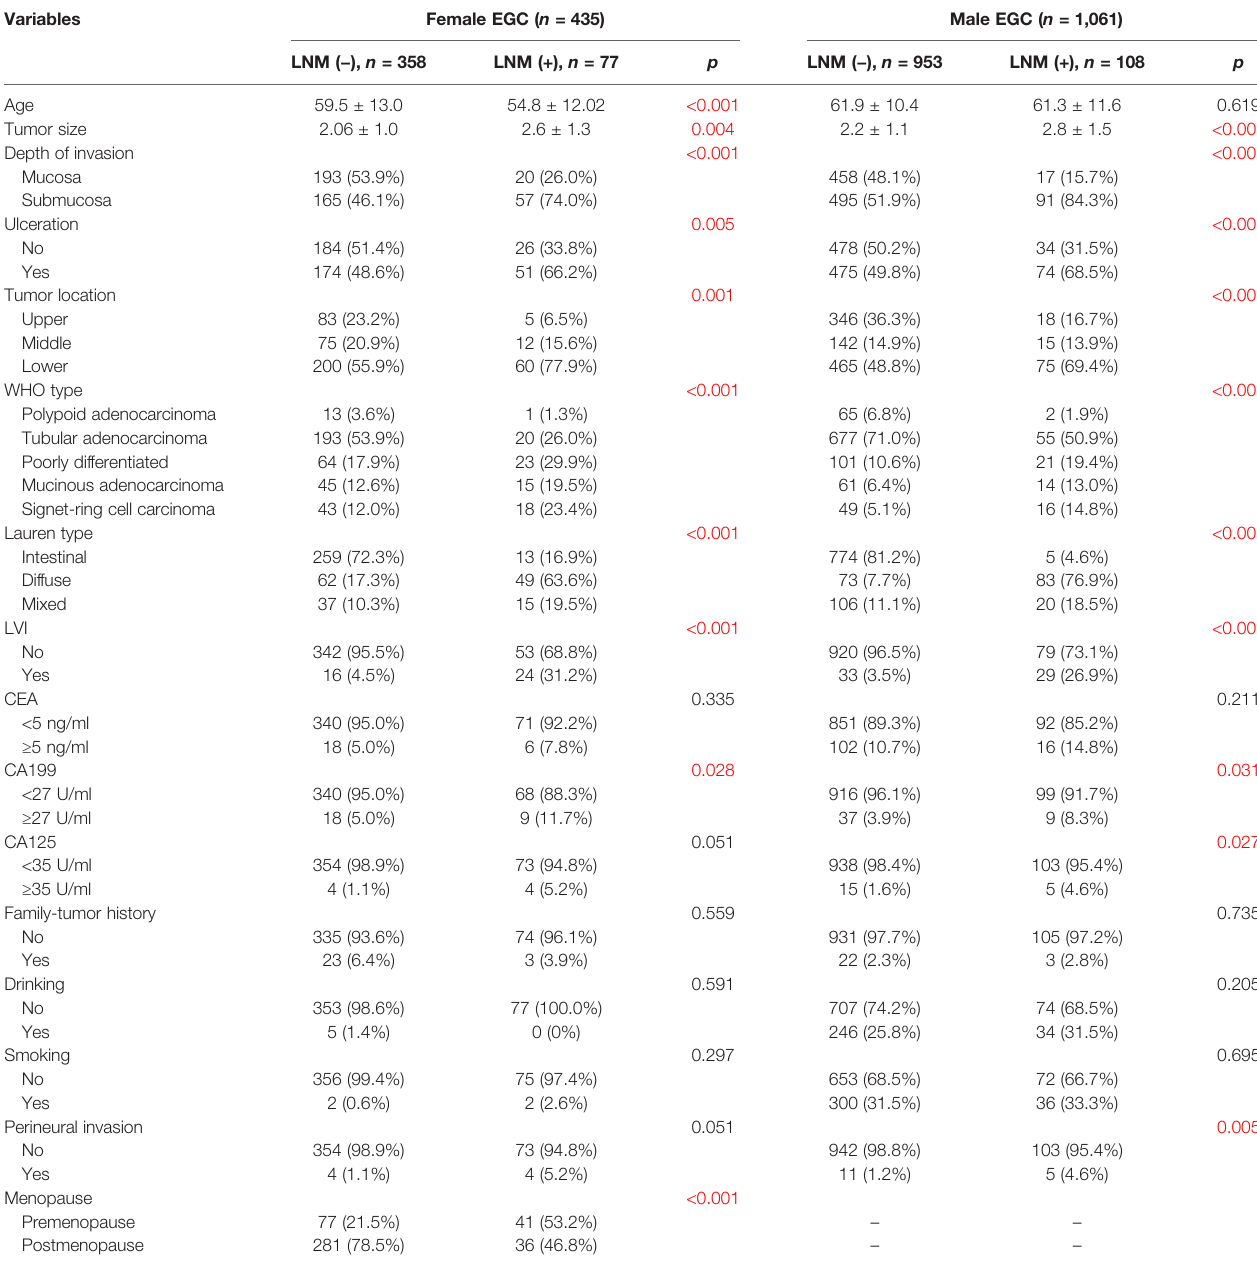
TABLE 2 | Predictive variables for LNM in EGC patients of training set by gender.